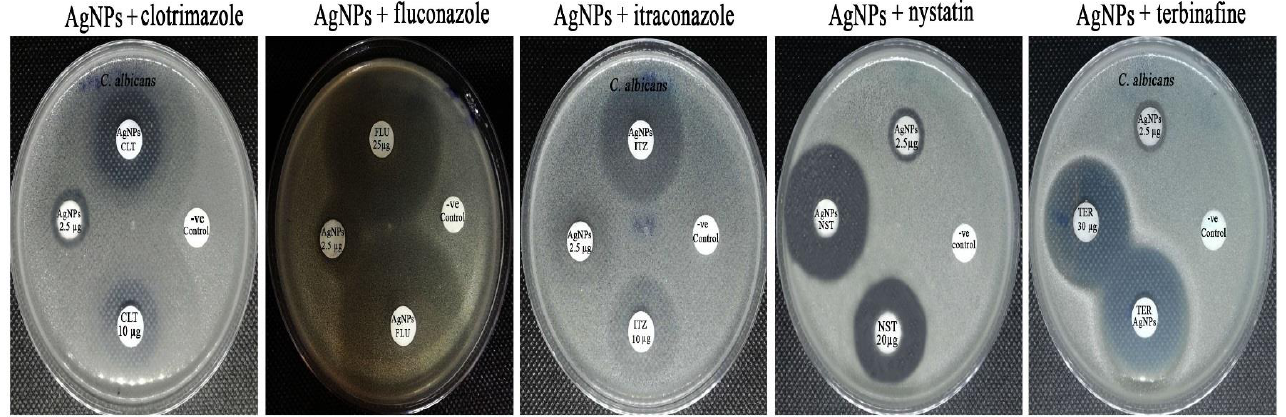
Figure 10. Synergistic pattern of biogenic AgNPs with different antifungal agents against C. albicans strain.